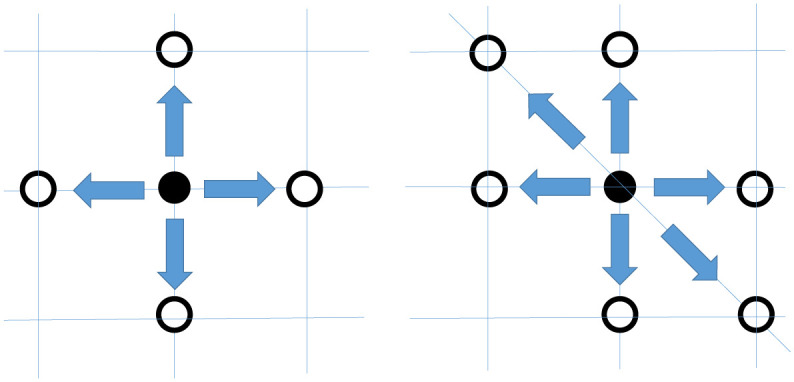
(a) ND-design, which does not allow for diagonal dose movement, and (b) D-design, which allows for diagonal dose movement.The filled circle indicates the current dose combination; the empty circles denote the candidate doses for escalation and de-escalation under the given design.